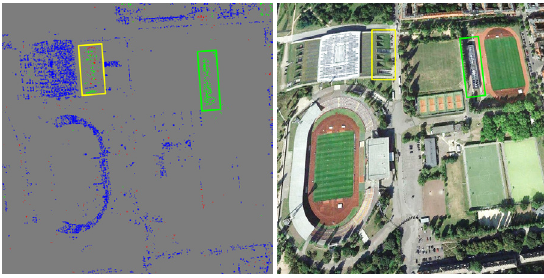
Figure 9. (a) Change detection image and (b) GE image (2014/09/05) for application of monitoring sports playgrounds. Yellow area, hybrid changes on stairway structure. Green area, erected